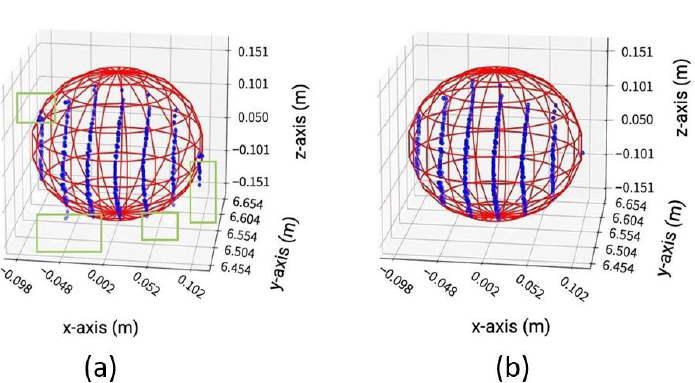
Figure 16. Comparison between sphere’s point clouds after initial S i and final S f LSSF. ( a ) Sphere point cloud after initial LSSF S i . ( b ) Sphere point cloud after final LSSF S f . The initial LSSF S i contains 381 points, and a 201.4mm sphere diameter ◦ is estimated from it. The final LSSF S f contains 306 points, and a 201.2mm sphere diameter ◦ is estimated from it.